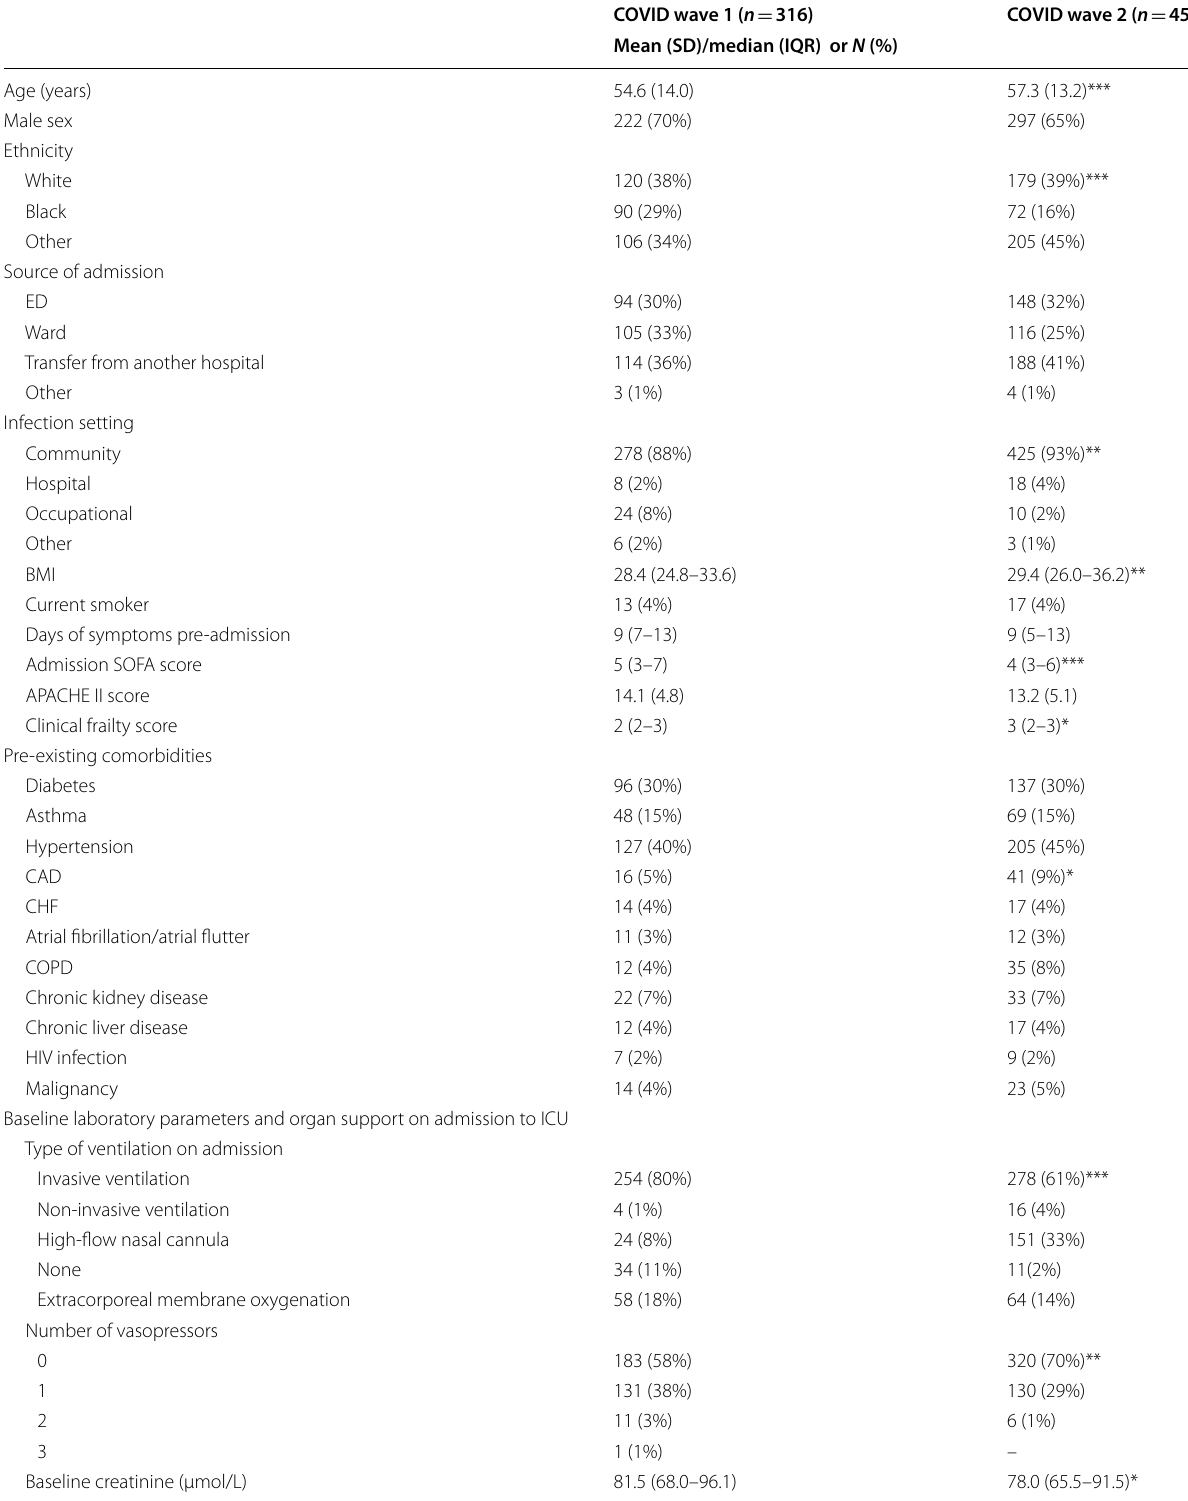
Table 1 Baseline characteristics, stratified by